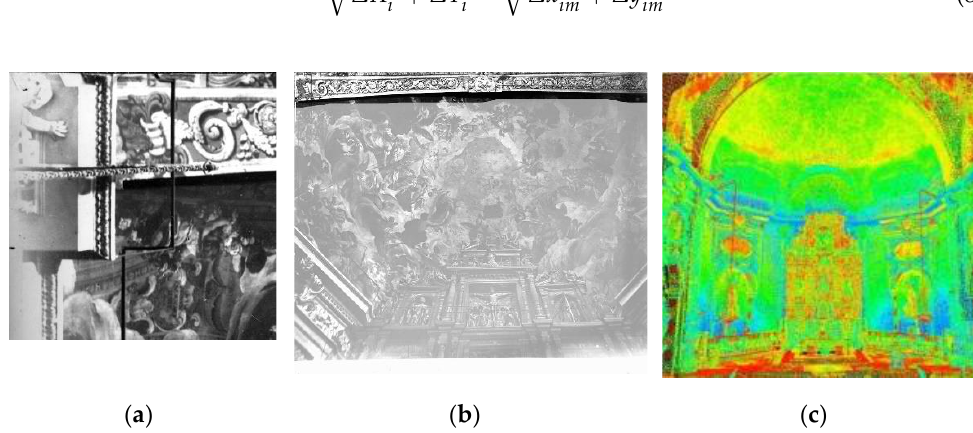
Figure 3. ( a ) Vertical element (lamp string). ( b ) Dimensional element (arc). ( c ) Point cloud (both).